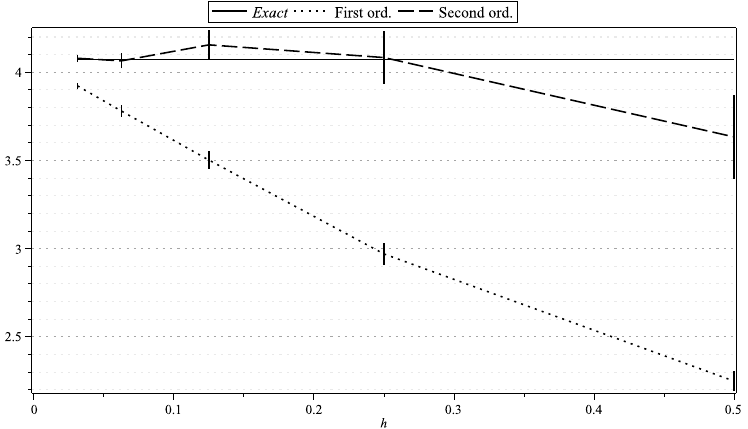
) 3 as functions of h : σ = 0.8, x 1